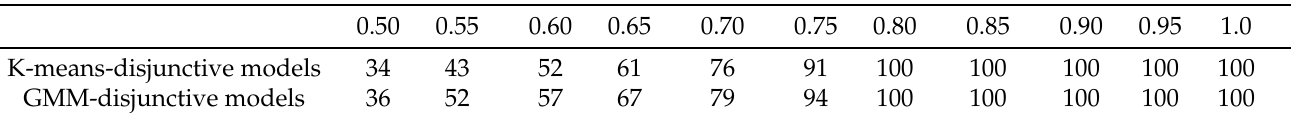
Table 1. The maximum numbers of the CCOPDs obtained from disjunctive models for different CTs. The decimals in the top row are the